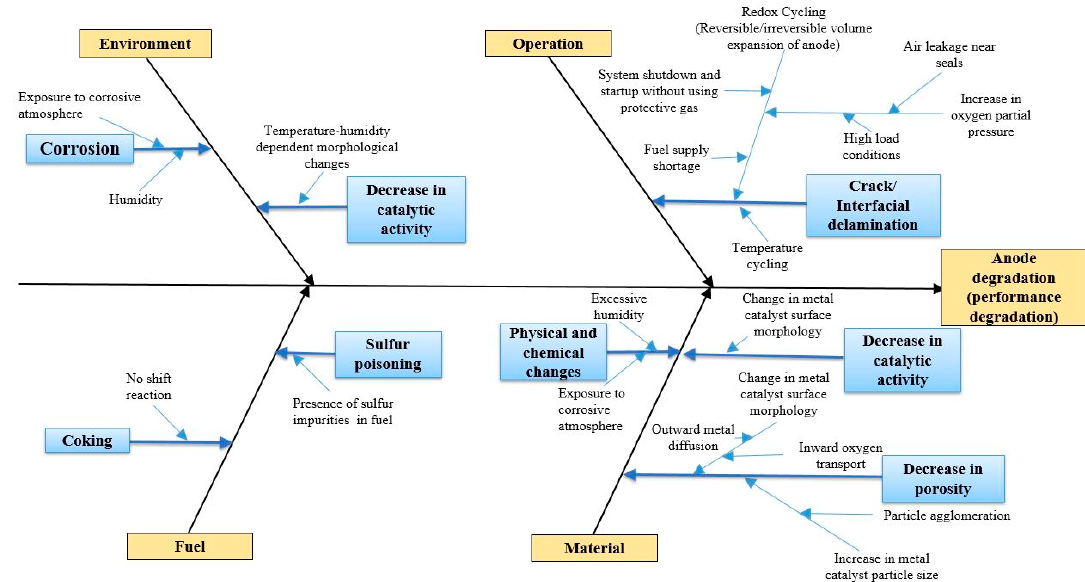
Figure 3. Ishikawa diagram for ceramic anodes.